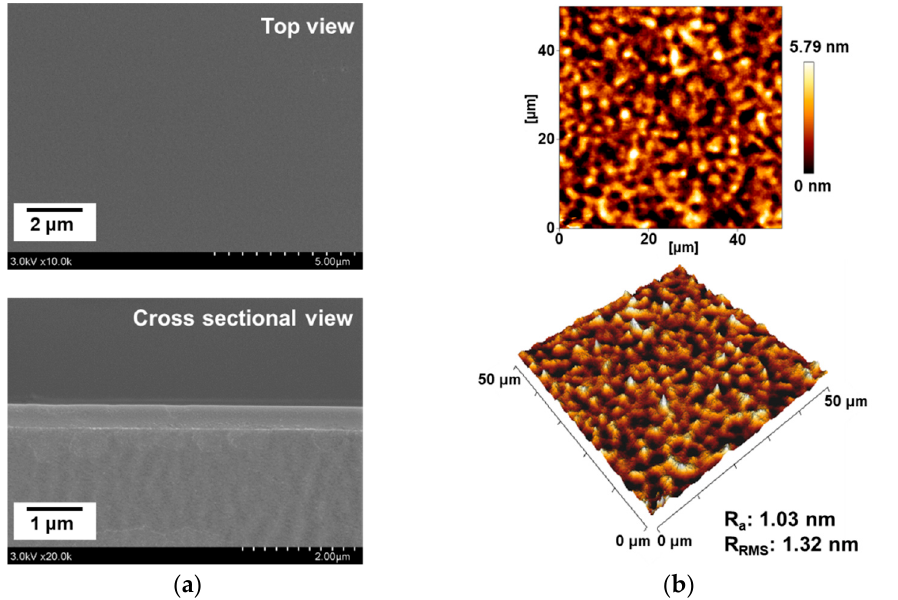
Figure 5. Surface characterization of the PANI film obtained on a glass substrate by using the newly designed AP-plasma reactor system for 60 min: ( a ) top-view and cross-sectional view of FE-SEM images; ( b ) two-dimensional and three-dimensional AFM images.